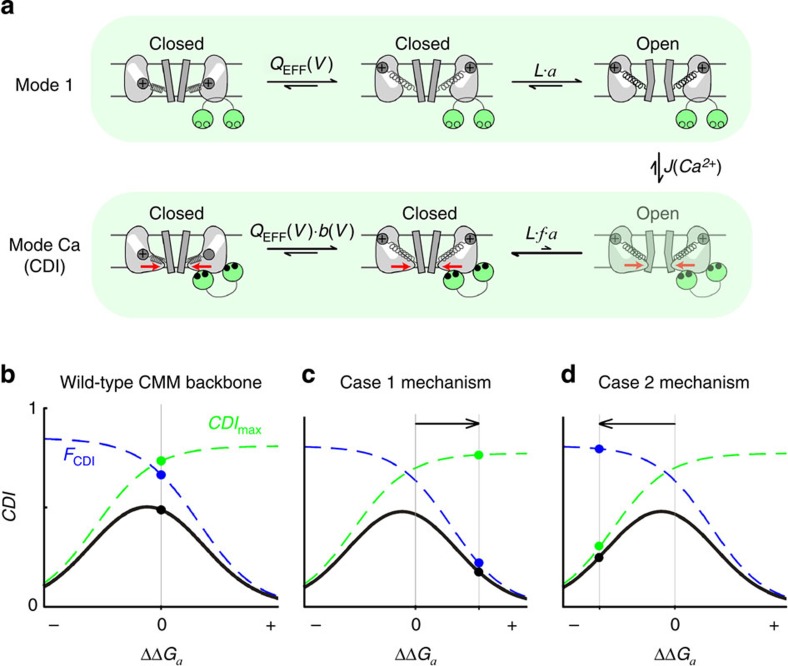
An allosteric model could explain a decrease in CDI.(a) An allosteric CDI mechanism924. Ca2+ (black circles) binding to CaM (green) drives channels into mode Ca, which exhibits lower open probability (PO). (b) The model predicts two main components of CDI. FCDI (blue) is the fraction of channels in mode Ca (dependent on J(Ca2+) and thus PO) and CDImax (green) results from the relative ability of the channel to open once in mode Ca. The combination of these two curves defines the total CDI of a channel (black). (c) Mutations which inhibit channel opening (ΔΔGa>0) decrease Ca2+ entry, reducing FCDI (blue). These channels will exhibit lower CDI (black) due to a decreased ability to populate mode Ca. (d) Alternatively, enhanced channel opening (ΔΔGa<0), increases openings in mode Ca, thereby decreasing CDImax (green) and overall CDI (black).